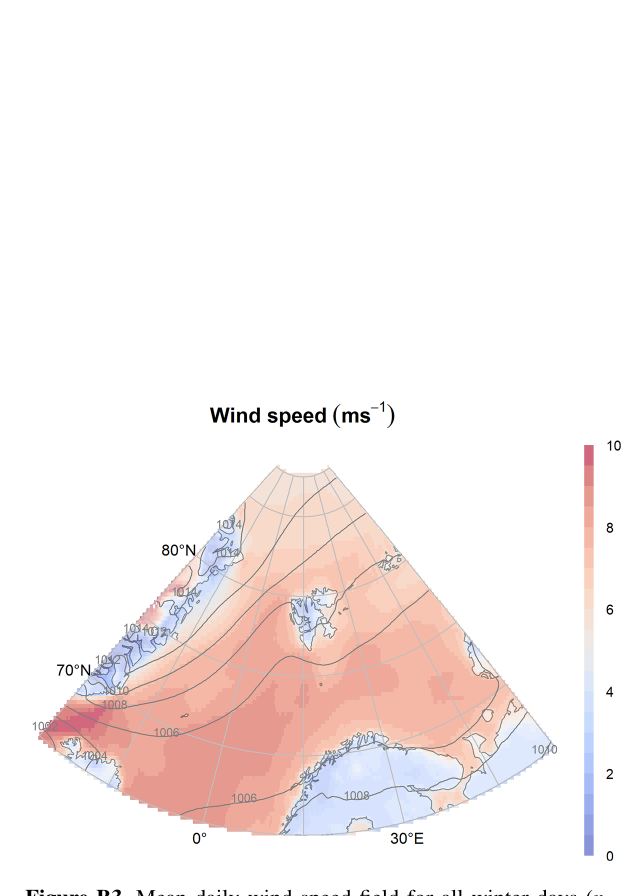
Figure B3. Mean daily wind speed field for all winter days ( n = 729) included in these analyses. This represents the mean daily wind speed conditions from which anomalies are calculated. Composite MSLP isobars for all winter days are included for